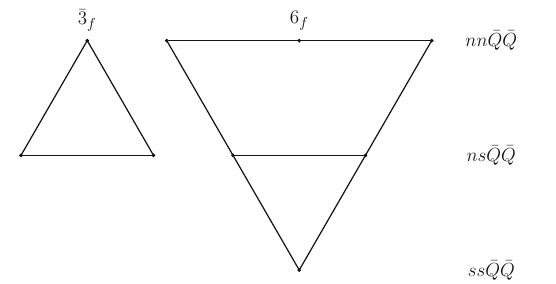
Fig. 1 Flavor representations for the qq ¯ Q ¯ Q systems. Here Q = c , b and q = n , s with n = u ,